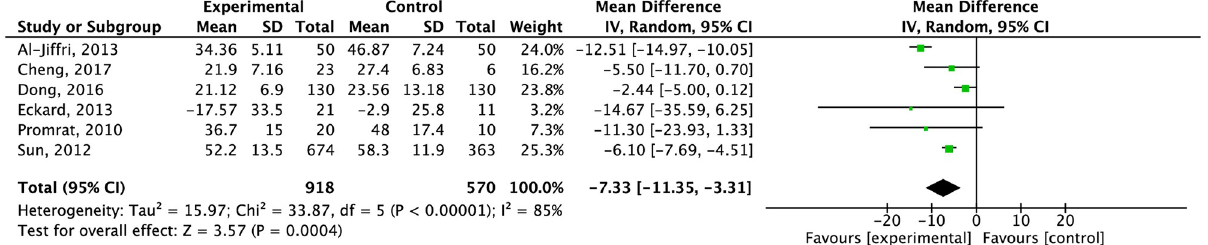
Fig 10. Effect of exercise plus diet compared to the control group in AST concentration.